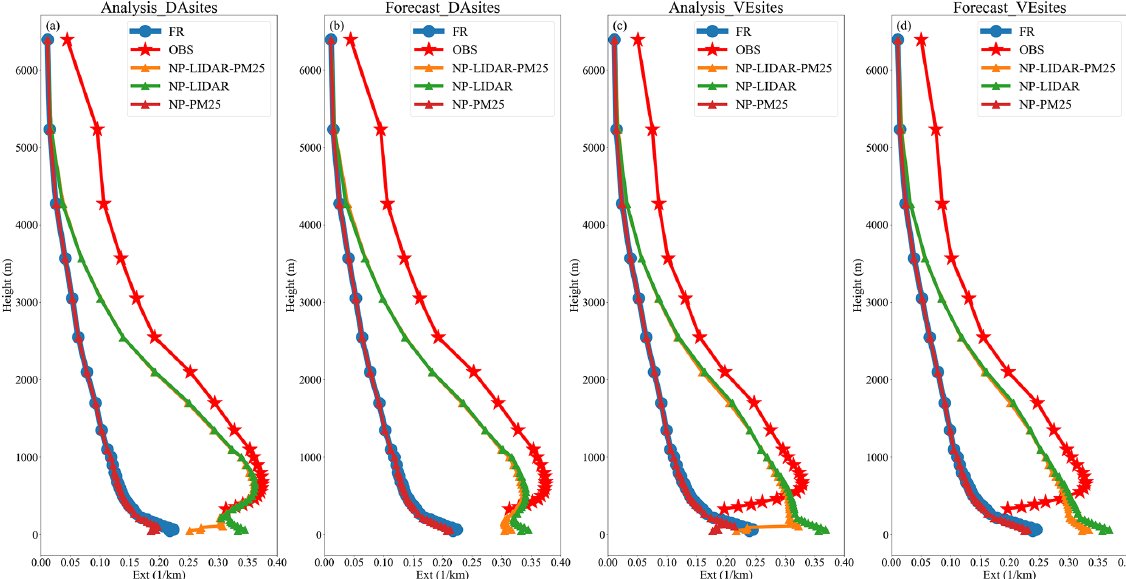
Figure 14. Vertical distribution of aerosol extinction coefficients in the analysis averaged among DA sites (a) , forecast averaged among DA sites (b) , analysis averaged among VE sites (c) , and forecast averaged among VE sites (d) in the FR, NP-PM25, NP-LIDAR, and NP-LIDAR-PM25 experiments and ground-based lidar